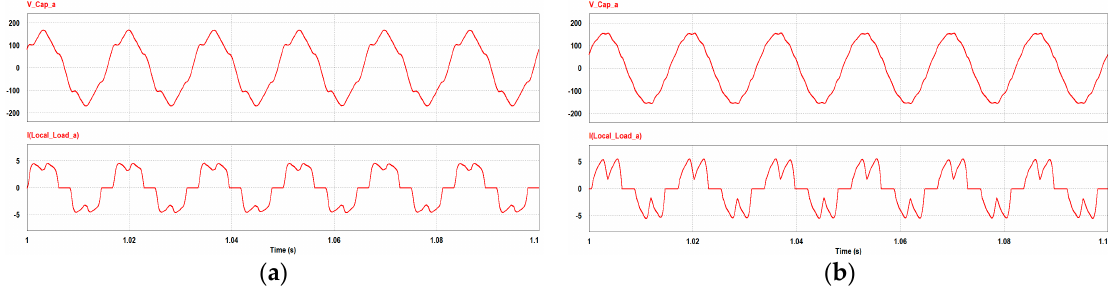
Figure 17. Simulation results during SSI mode: ( a ) Without harmonic compensation; (b ) with harmonic compensation. (From top to bottom: Measured a -phase inverter output voltage, a -phase local load current, instantaneous angular frequency of output voltage, and GS status signal).